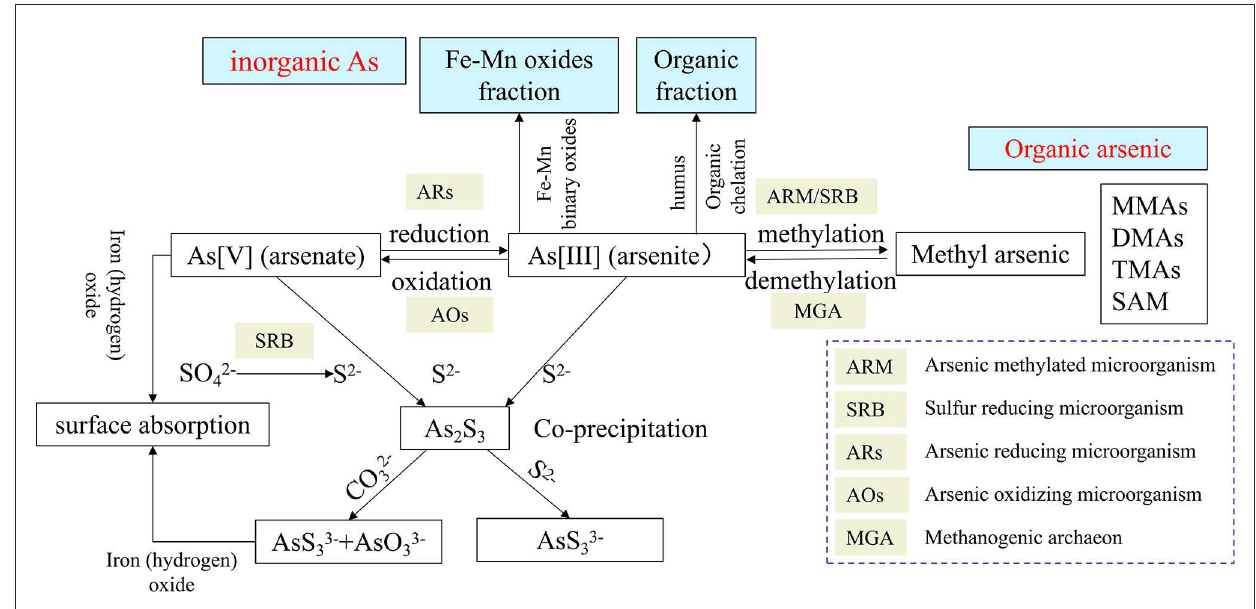
FIGURE1 Biogeochemical processes of arsenic and functional microorganisms involved.